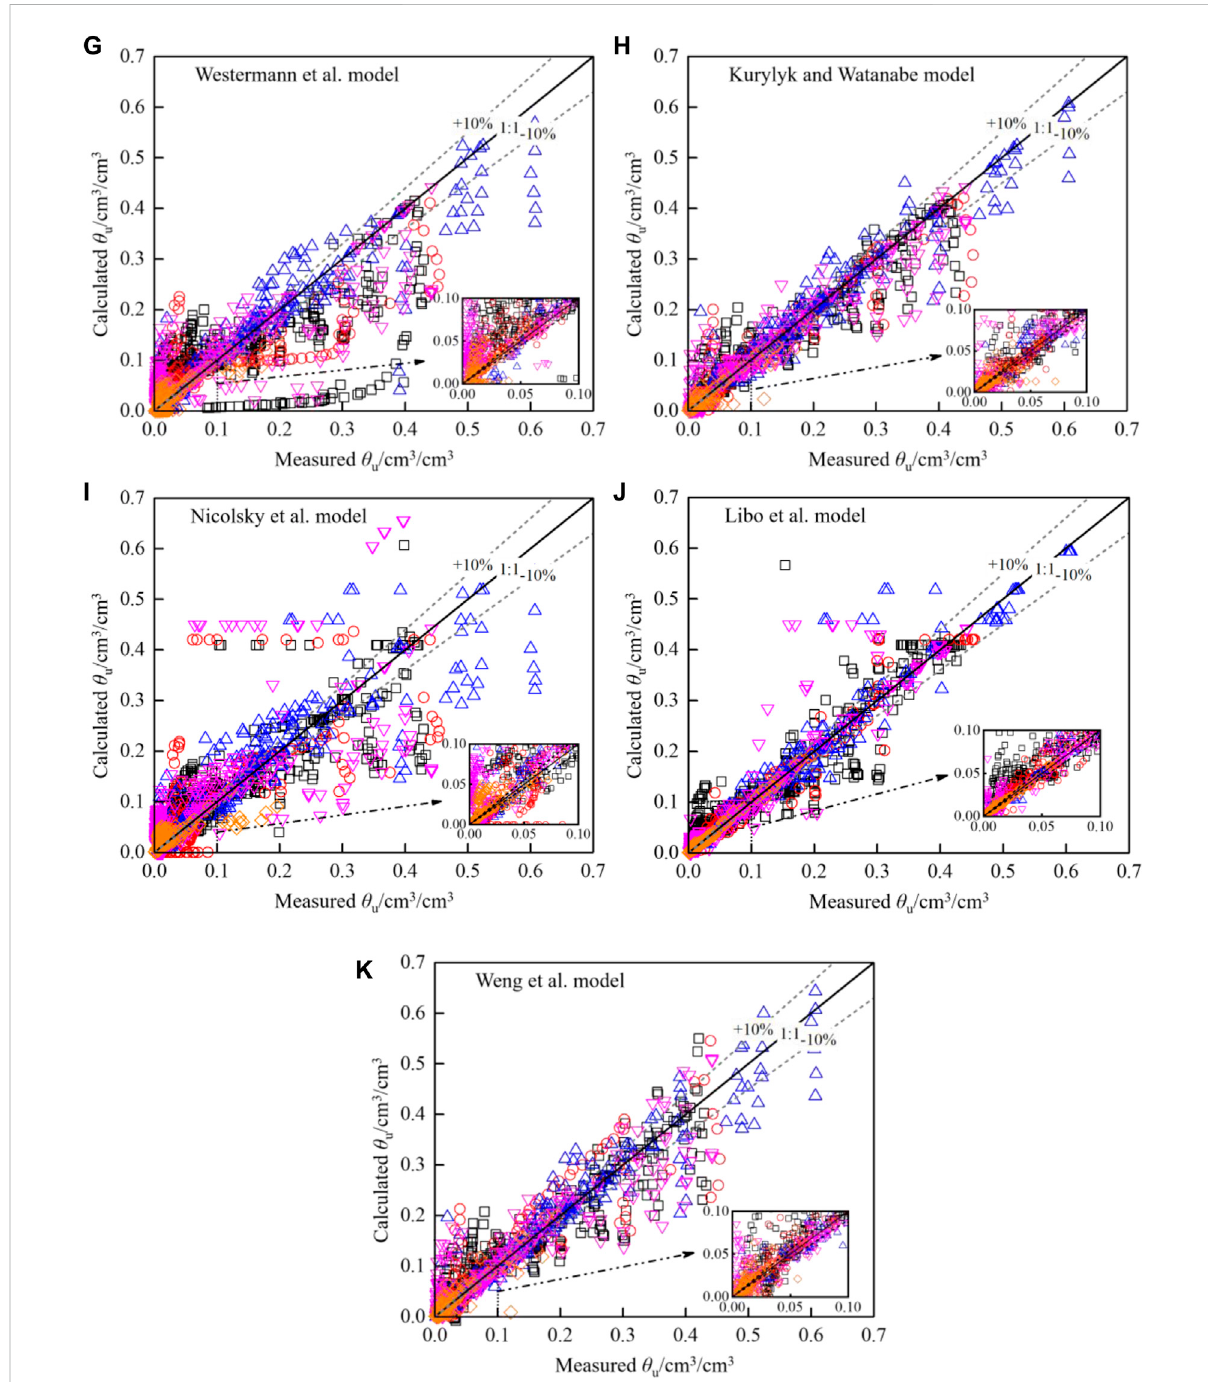
stands for silt, magenta down triangle stands for sand, and orange rhombus stands for